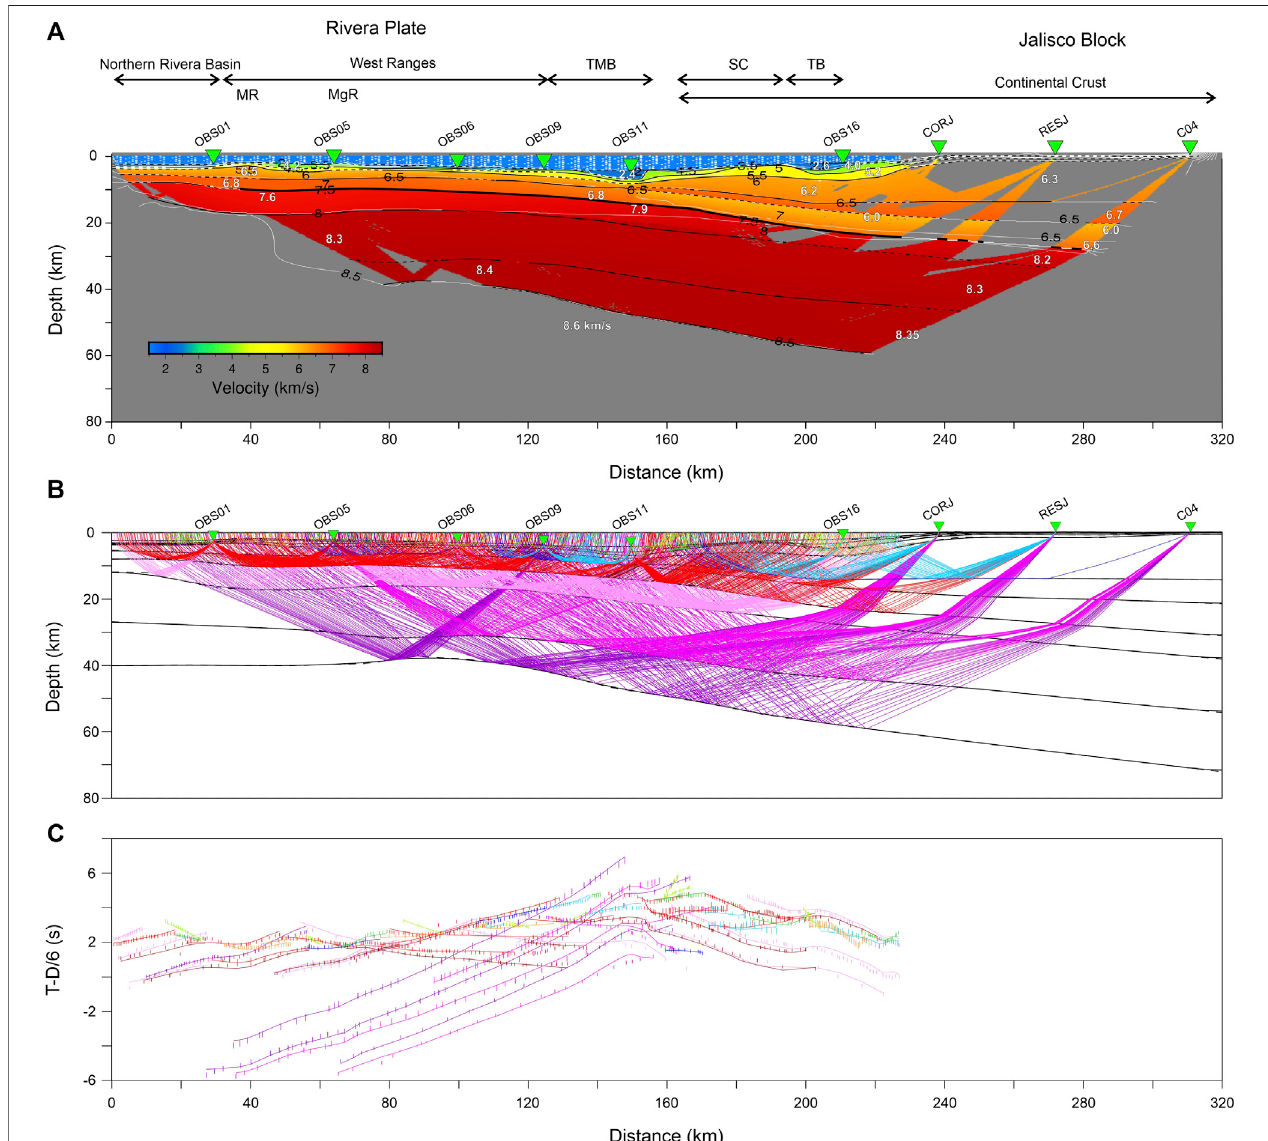
FIGURE7 |(A) Final RTSIM02 P-wave velocity model acrossthe western regionof Islas Marías (Mexico). Black inverted triangles depict land stations of theTsuJal RTSIM02 seismic pro fi le. Vertical and horizontal axes show depth below sea level and model position, respectively. The colored area is the region where ray tracing provides thevelocity values. Black lines describe layer boundaries,and the thick onesmark positions where rays are re fl ected, showing the well-de fi ned areas. Thegray zone representsthe areanotcrossedby rays. (B) Ray tracingand velocity modelwithaveragevelocitiesin km/s. (C) Comparison between observed (verticalbars) and calculated (lines) travel times. In all panels, distances refer to the velocity model origin. Abbreviations : MgR , Magdalena range; MR , María range; SC , Sierra de Cleofas; TB , TsuJal basin; TMB, Tres Marías basin.